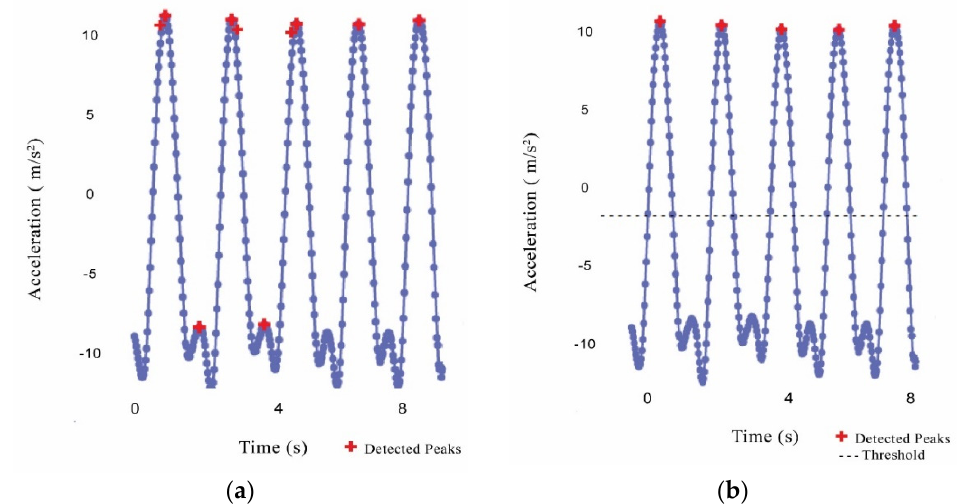
Figure 4. Detected peaks in acceleration signal: ( a ) Initial selection of peaks; ( b ) After applying threshold and minimum distance.